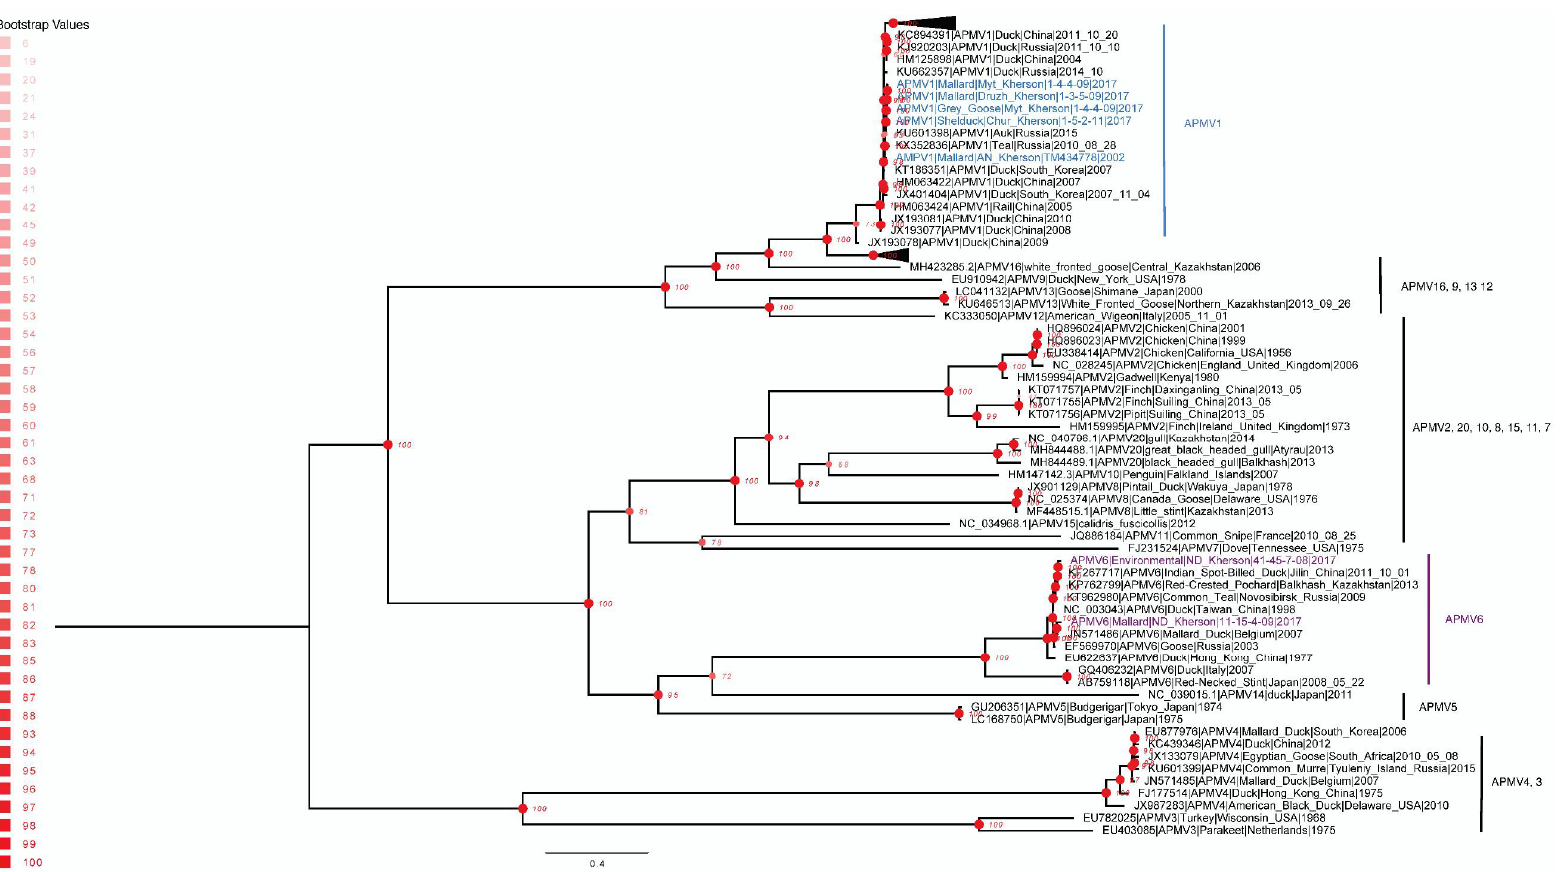
Figure 3. Global phylogenetic analysis comparing APMV-6 and APMV-1 with all avian avulavirus subtypes. Maximum likelihood tree showing evolutionary relationships among 322 full-length APMV sequences, including the seven sequenced in this study, and the phylogenetic position of Ukraine APMV-6 and APMV-1 sequences within their subtypes. APMV-1 strains sequenced in this study are highlighted in blue, and APMV-6 sequenced from this study are highlighted in purple. Eighty-nine full-lengthh segments are displayed, and the remaining 233 sequences are collapsed at the top of the tree. The collapsed sequences are all APMV-1 subtypes. Nodes indicate maximum likelihood bootstrap support under using bestTree and visualized in FigTree v.1.4.4 with a midpoint tree root.